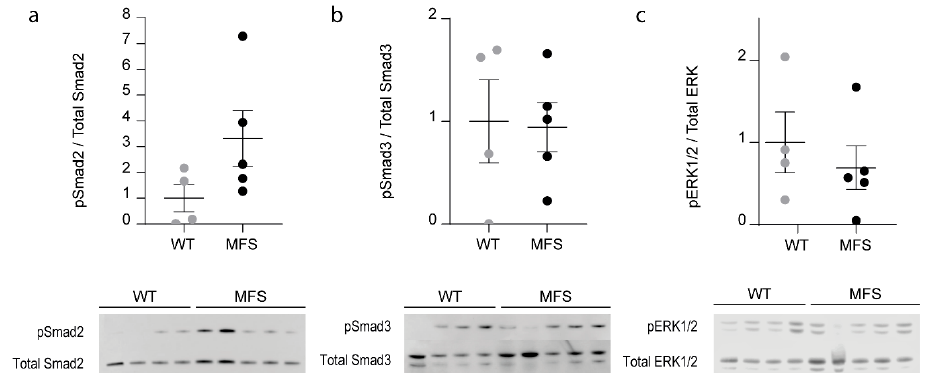
Figure 5. Canonical and non-canonical TGF β -dependent signaling in the myocardial tissue of 3- Figure 5. Canonicalandnon-canonicalTGF β -dependentsignalinginthemyocardialtissueof3-month-old male WT and MFS mice ( n = 4 and 5, respectively). ( a ): no significant difference could be observed in Smad2 activation (pSmad2 / Total Smad2) between the MFS mice and their WT littermates (Mann–Whitney